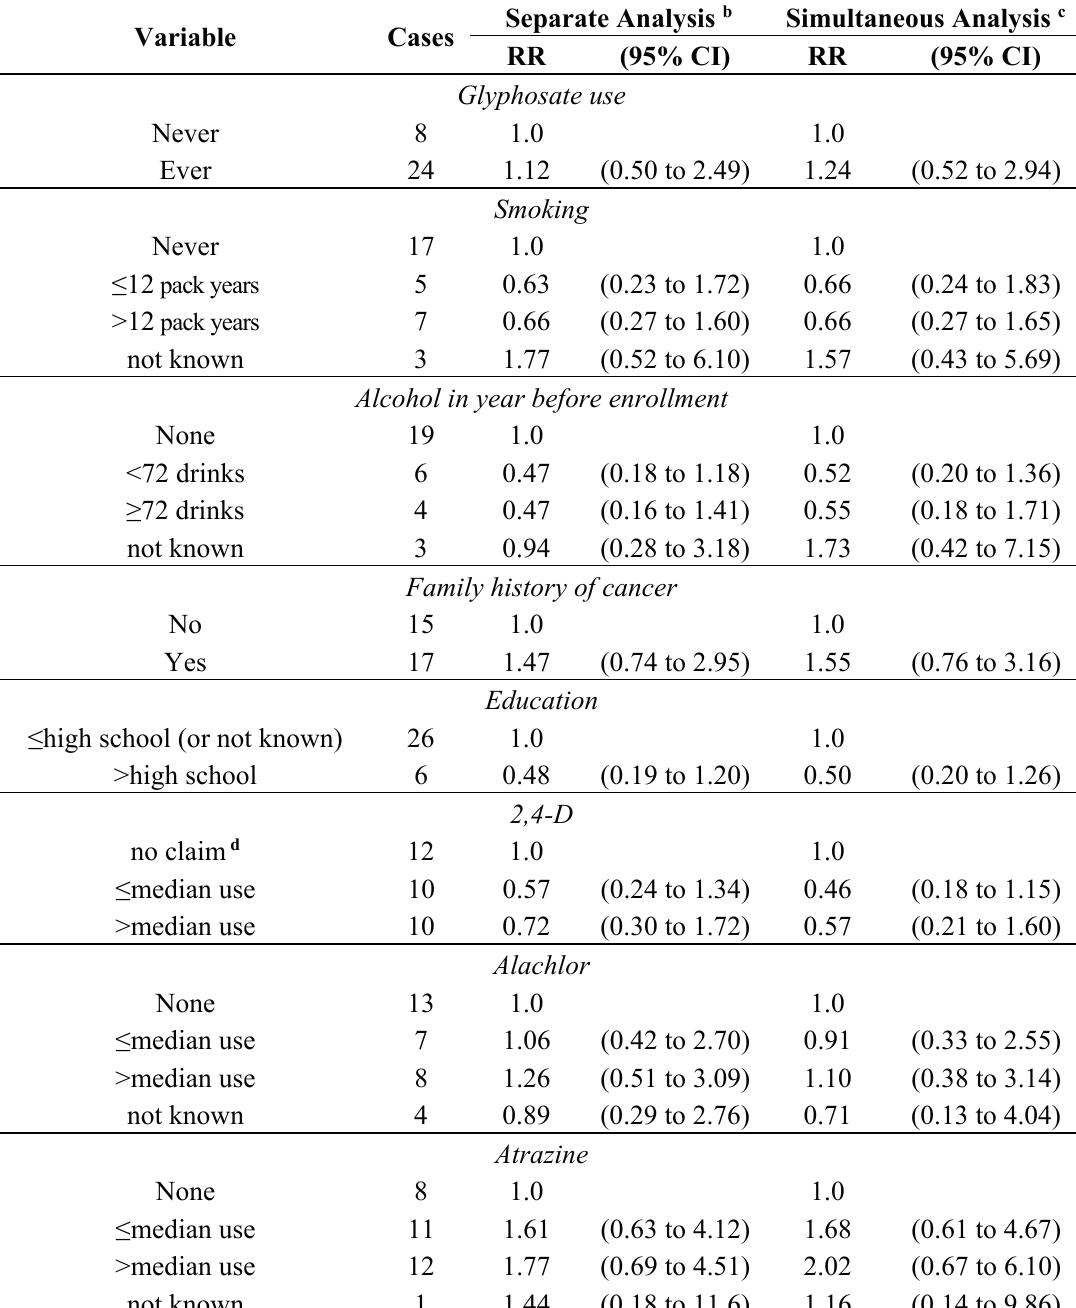
Table 2. Estimated risks of multiple myeloma from the AHS study in relation to use of pesticides and other variables (32 cases (29 males, 3 females) in 54,315 applicators, Set 1 data a